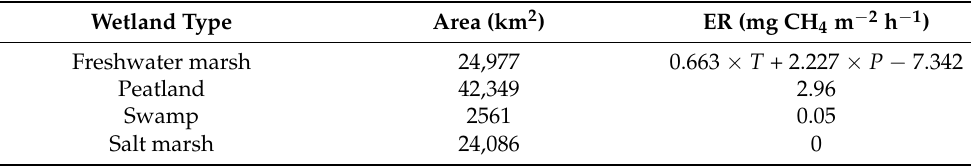
Table 3. CH 4 Emission factors and area of different types of wetlands in China. Wetland Type